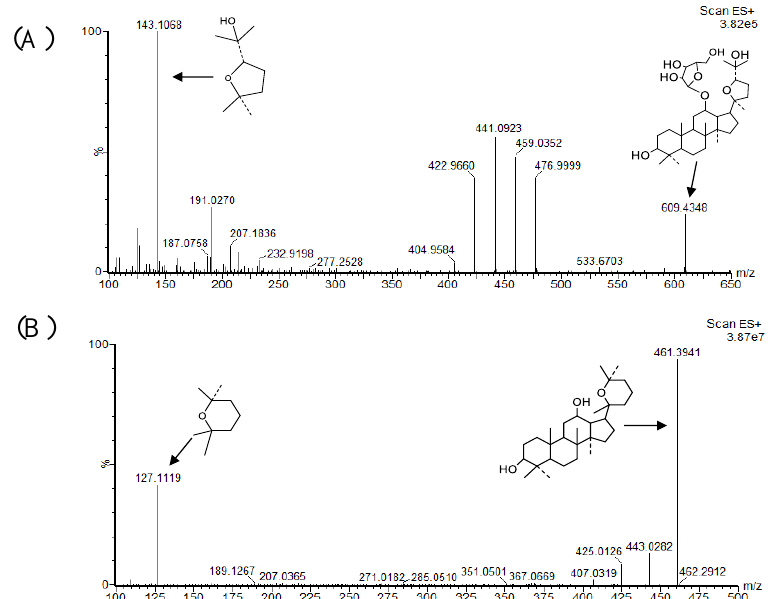
Figure 1. Mass spectra and the proposed patterns of fragmentation of RPDQ ( A ) and internal standard (IS) ( B ).